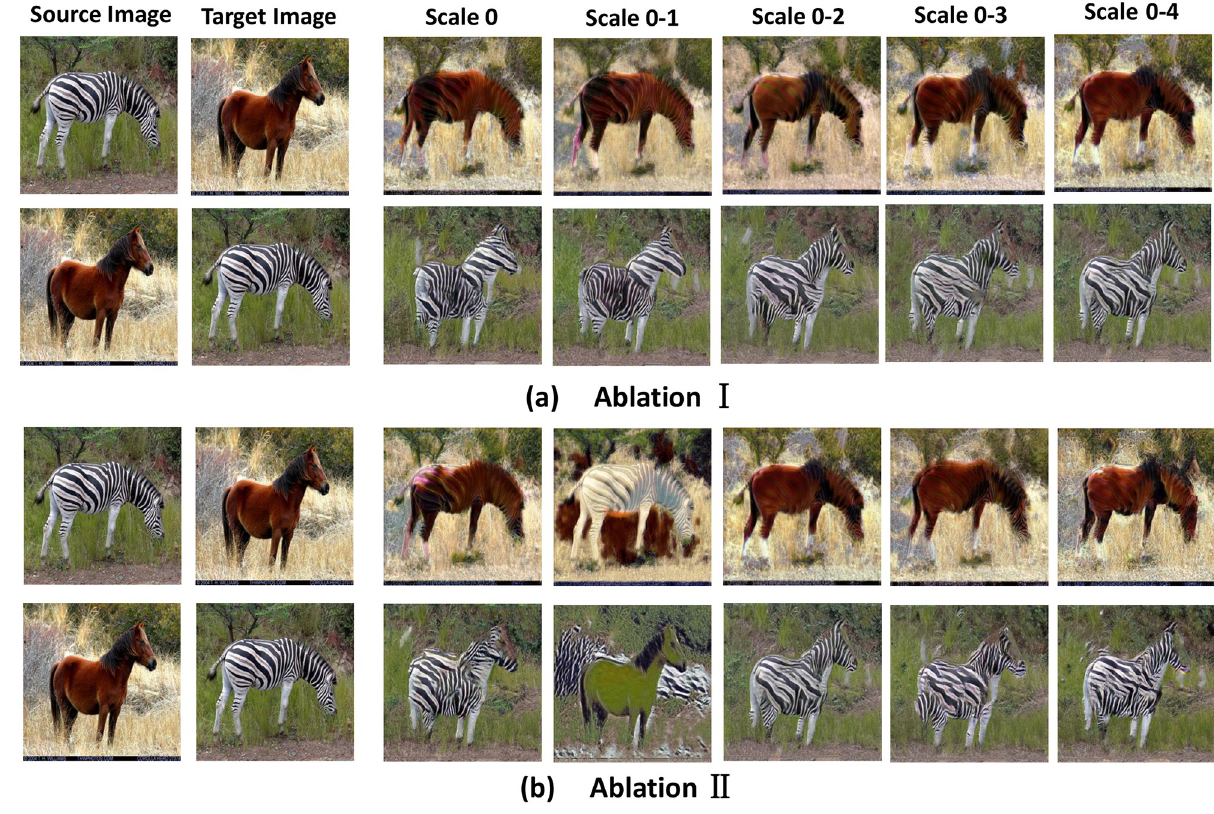
Fig 11. Visual results of parametric study.